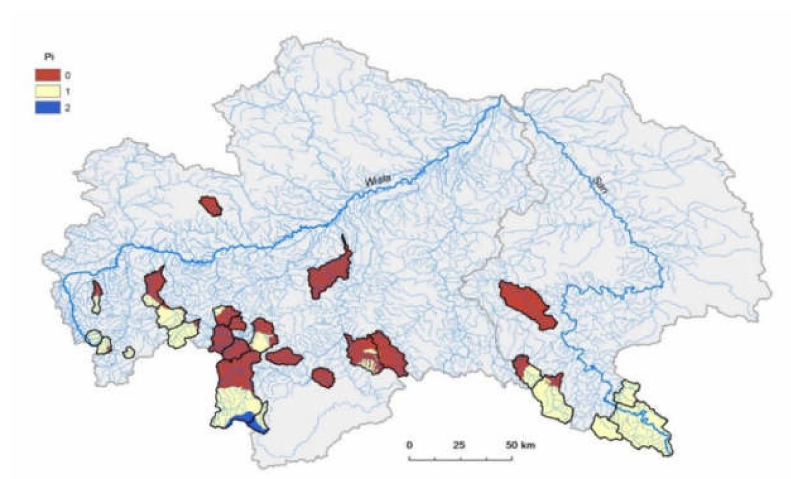
Figure 7. Climatic water balance ( Pi ) of analyzed catchments in the Upper Vistula basin.